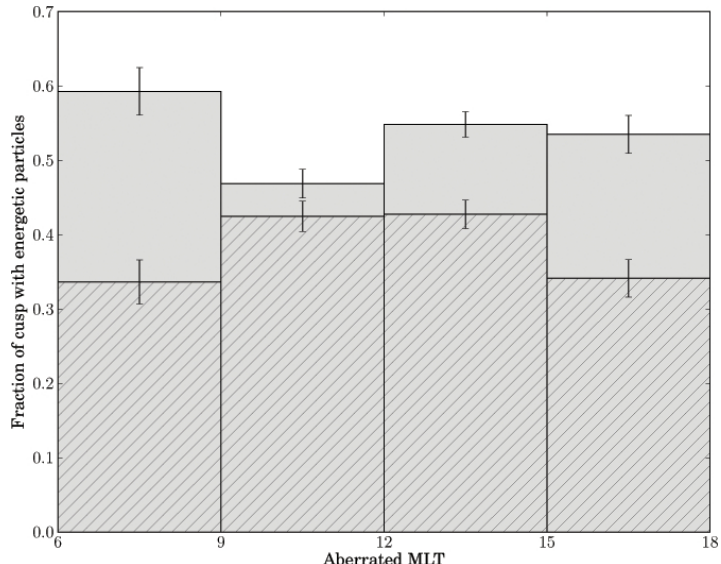
Fig. 6. Fraction of time spent in the cusp which also had energetic particles present, by magnetic local time (corrected for solar wind aberration). Hashed bars had no GOES dipolarizations within preceding four hours; solid bars had at least one dipolarization within the preceding four hours. Error bars are derived from binomial statistics, as explained in the